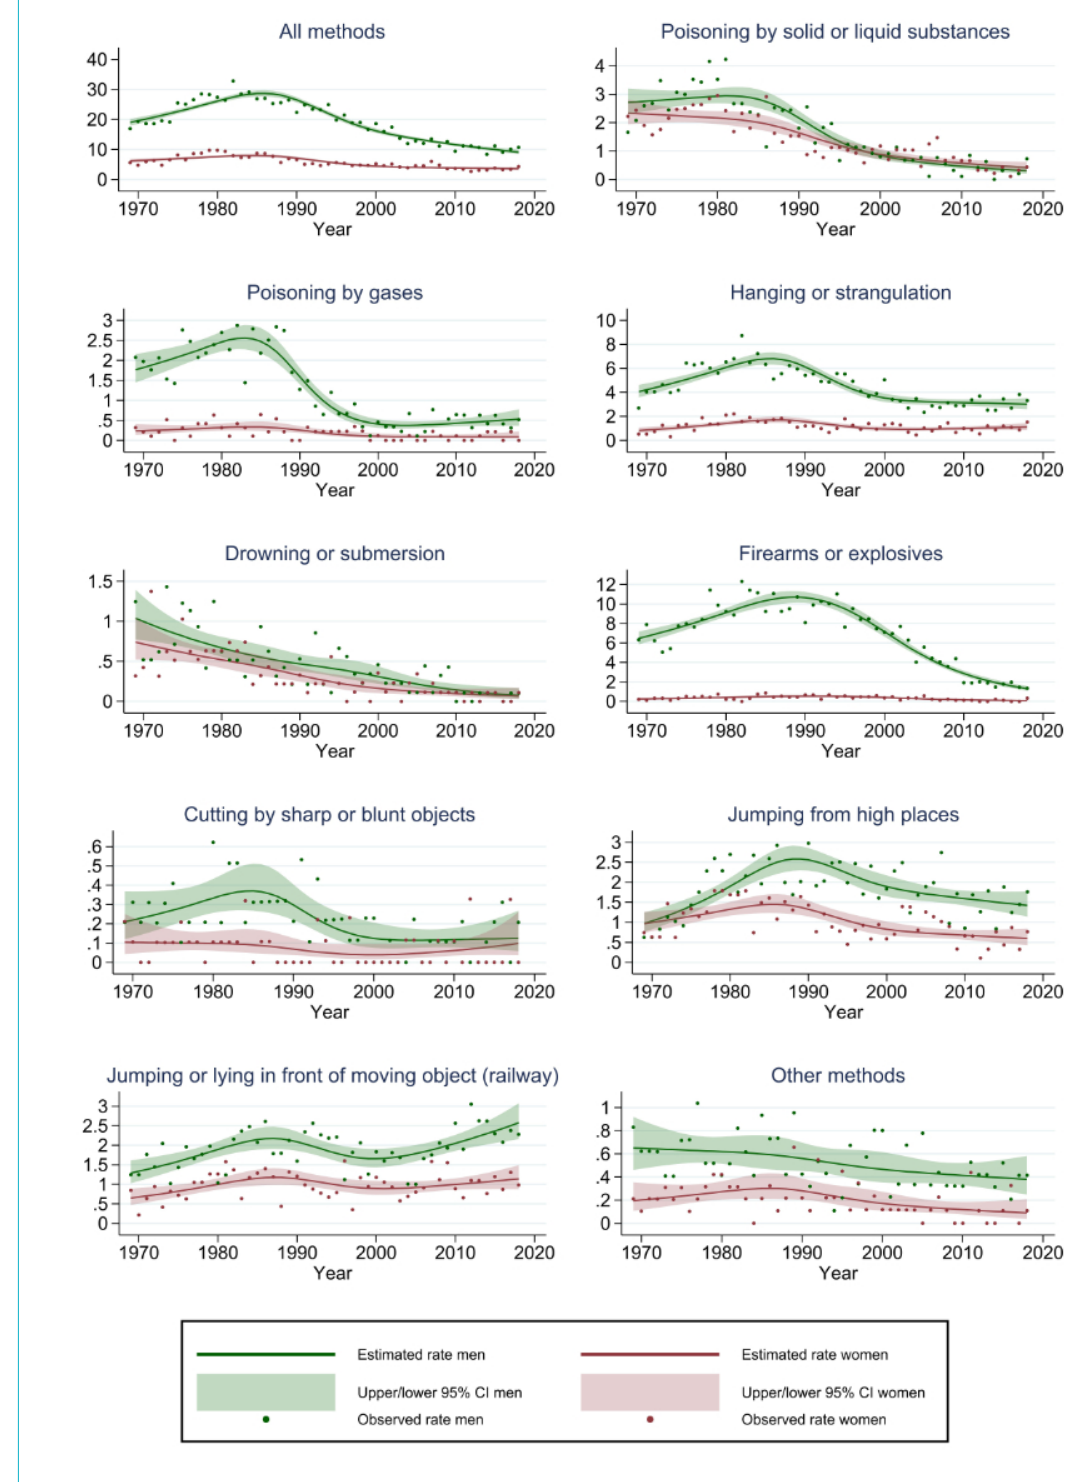
Figure 2: Rates of suicide methods per 100,000 population (person-years) in the age group 10–29 years. Note: estimated true rates and as- sociated confidence intervals (CI) were derived from Poisson regressions using a restricted cubic-spline